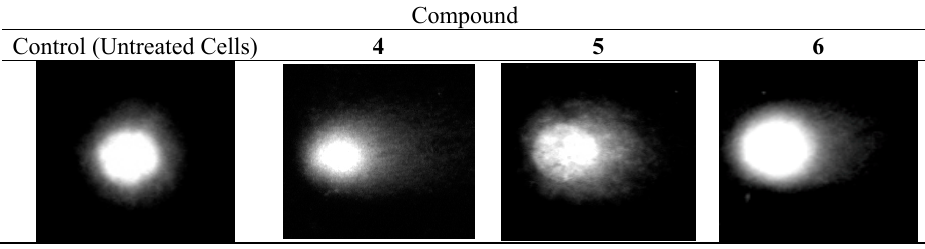
Figure 5. Relative activity of TrxR in human cancer cells treated with complexes 4 , 5 and 6